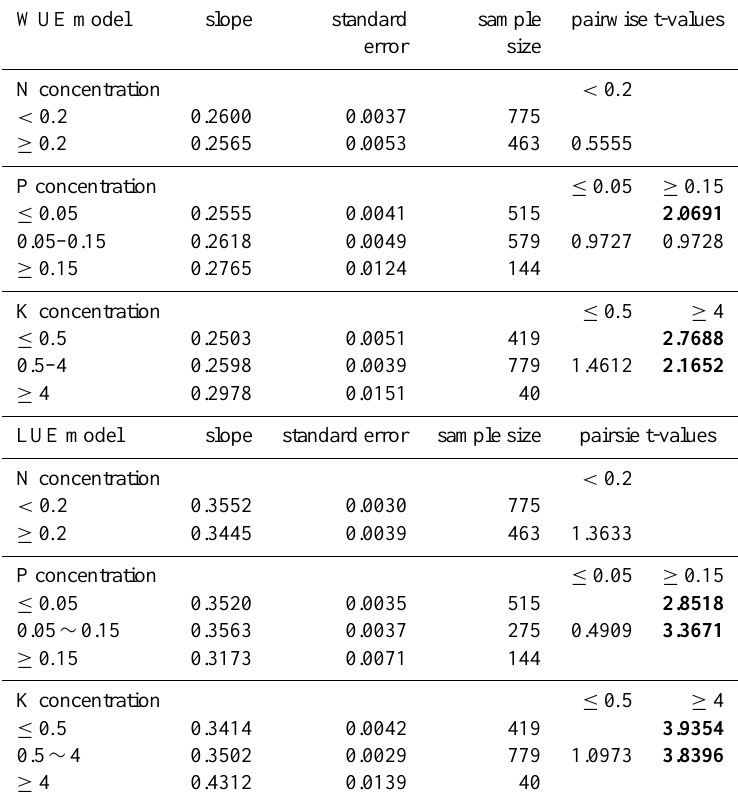
Table 2. Regression slopes of observed NPP against Level 1 WUE and LUE model predictors for different soil nutrient levels, and t-values for all pairwise comparisons among the levels (bold: P < 0 . 05 or better).